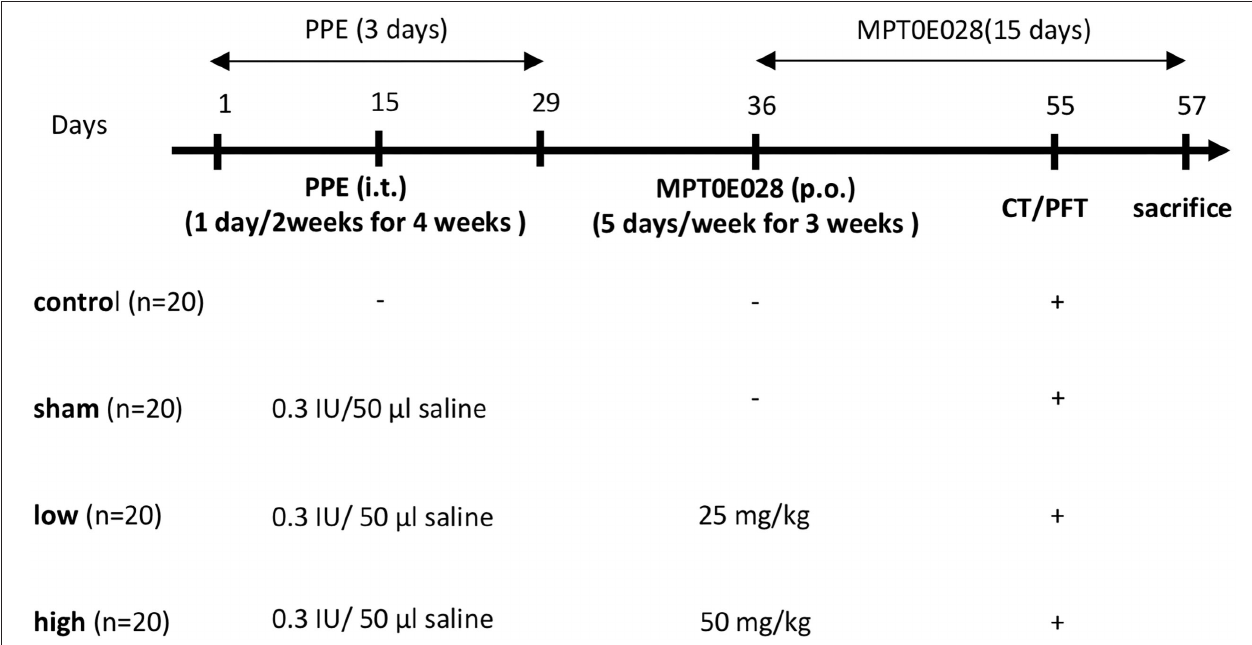
FIGURE 1 | Illustration of the experiment design. Mice in the emphysema group ( n = 60) were intratracheally instilled with 0.3 IU/50 µ l phosphate-buffered saline (PBS) containing porcine pancreatic elastase (PPE) 1 day/2 weeks for 4 weeks. Mice in the control group ( n = 20) received 50 µ l of PBS at the same intervals. After PPE administration, mice in the emphysema group were randomly orally administrated 0 (sham group), 25 (low group), or 50 mg/kg body weight (high group) of the MPT0E028 five times/week for 3 weeks. Lung function tests and chest CT images were conducted a day before